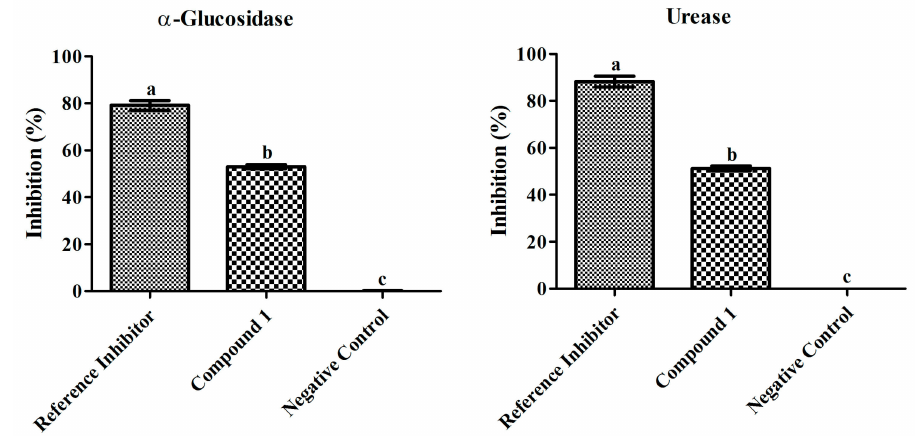
Figure 3. Inhibitory effects of compound 1 (100 µ g mL − 1 ) and reference inhibitors (80 µ g mL − 1 ) on α -glucosidase and urease. The graph values are standard error of means of three replications. The acarbose and thiourea was used as reference inhibitor for α -glucosidase and urease. Bars with different letters are significantly different at p ≤ 0.05 based on Duncan multiple range